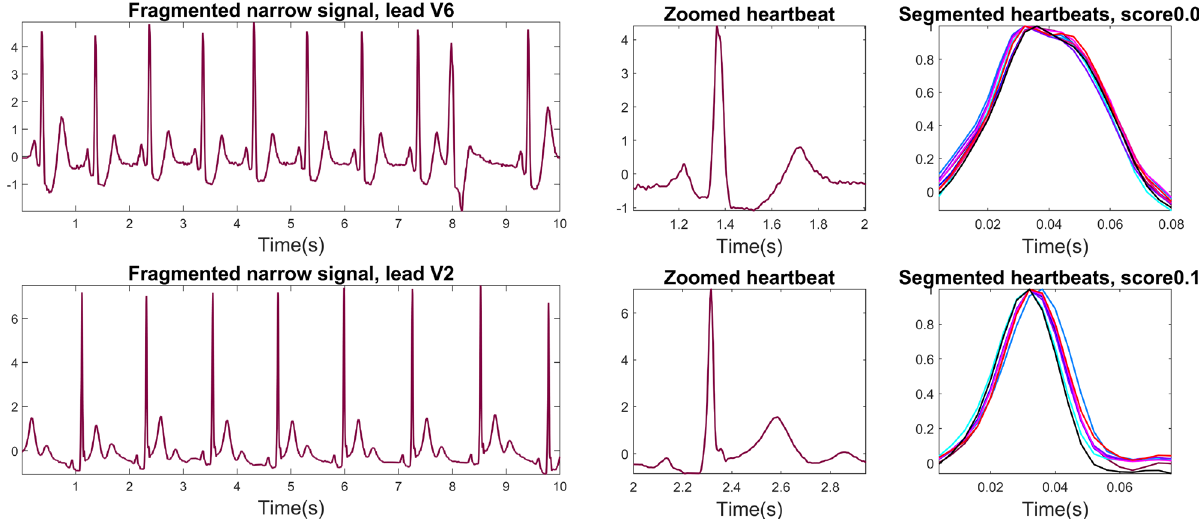
Figure 10. Example of two narrow QRS signals where the labels and the automatic score disagree (low algorithm score for fragmented signals). The top signal shows slight fQRS in the R-peaks, visible in the zoomed heartbeat and in the segmented heartbeats. The second presents fragmentation on the S wave, which lead to errors in QRS delineation and hence on